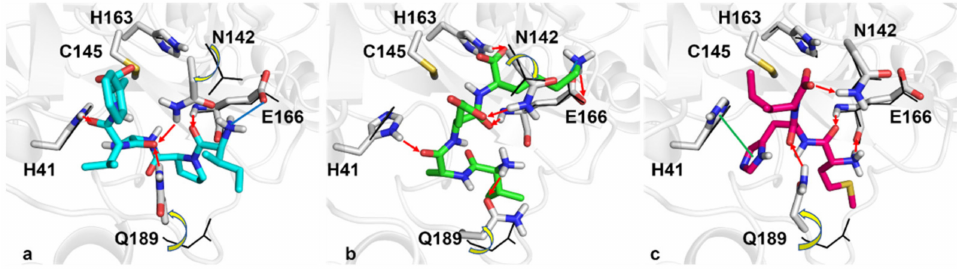
Figure 1. Panels ( a – c ) report the best pose returned from docking simulations for IPAVF (cyan sticks), IAEK (green sticks), and MHI (magenta sticks) peptides, respectively. Red arrows and green and blue lines depict hydrogen bonds, π - π , and electrostatic interactions, respectively. Black wireframes show the original side-chain conformation of the 7L0D crystal structures. Yellow arrows highlight the shifting of the side chains from their original positions, due to the induced fit.